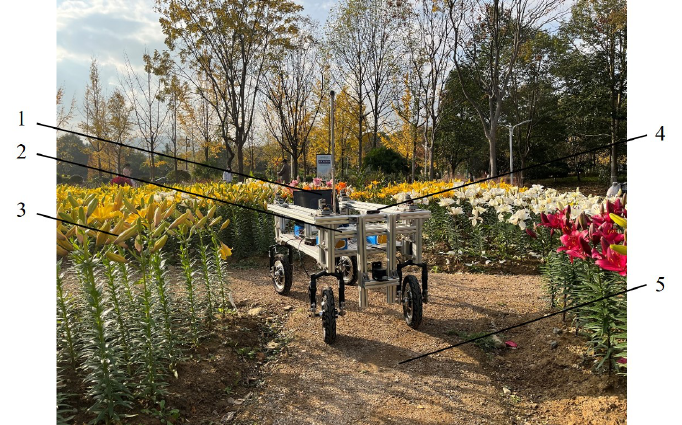
Figure 11. Experimental environment. 1. PC; 2. experimental platform; 3. flowers; 4. Intel RealSense D435i; and 5. unstructured path.